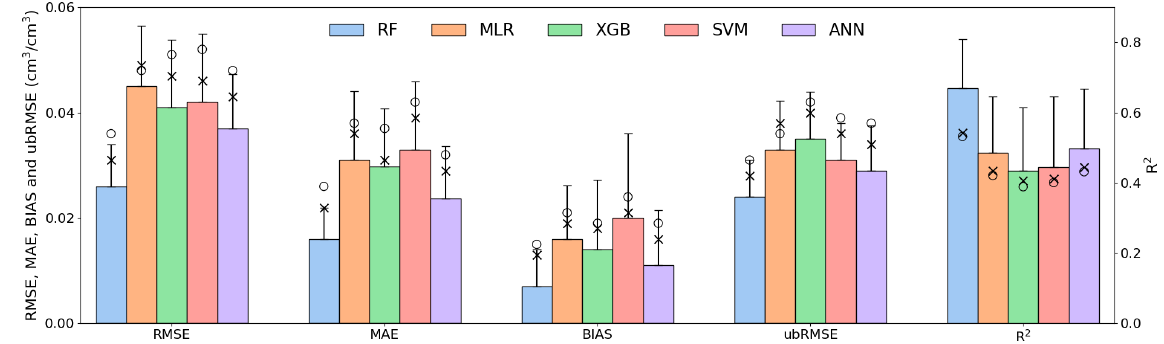
Figure 10. Comparison RF-based model with other models (i.e., MLR, XGB, SVM, and ANN). Error bars denote 1 σ errors. The “x” symbol represents the accuracy metrics of models excluding the residual calibration, and the “o” symbol represents the accuracy metrics of the models that use the global regression rather than the regional regression based on the spatiotemporal window searching strategy.